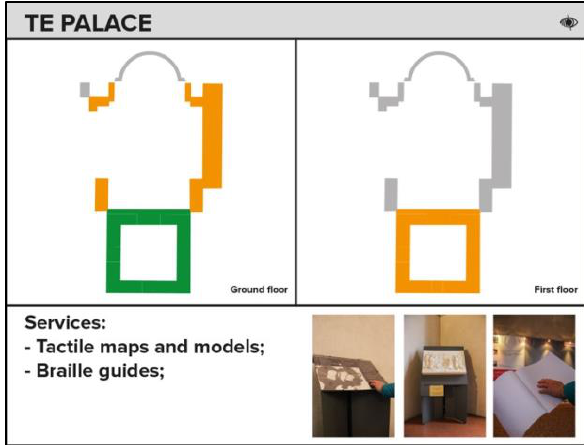
Figure 11. Graphic simulation of a possible pop-up window reachable from the map, after setting the visual impairments user profile, that could provide accessibility information about a specific POIs © Sebastiano Marconcini,